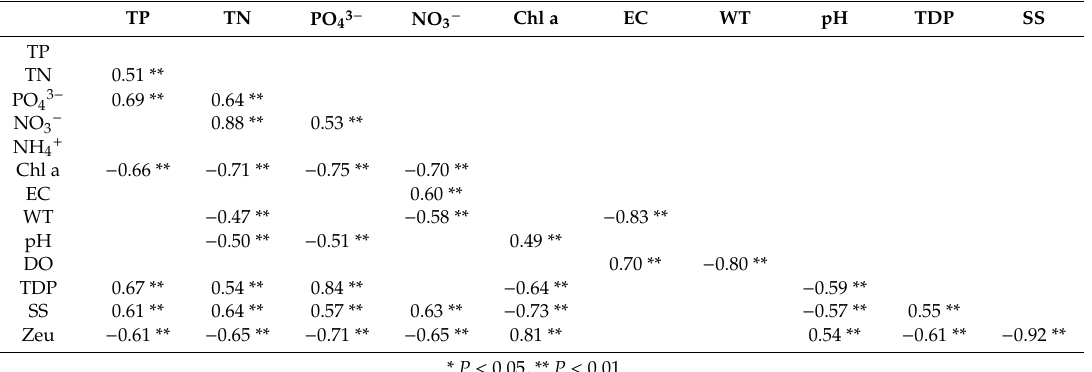
Table 2. Significant Spearman correlations among 13 environmental variables in the studied area (n = 48).